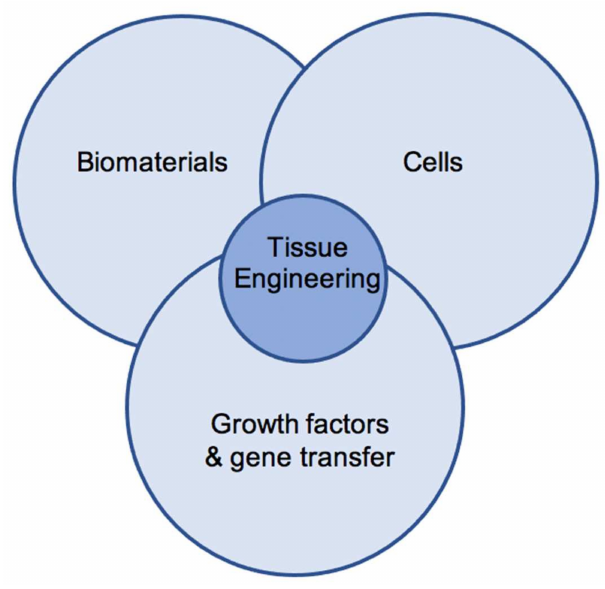
Figure 1. The triade of cartilage tissue